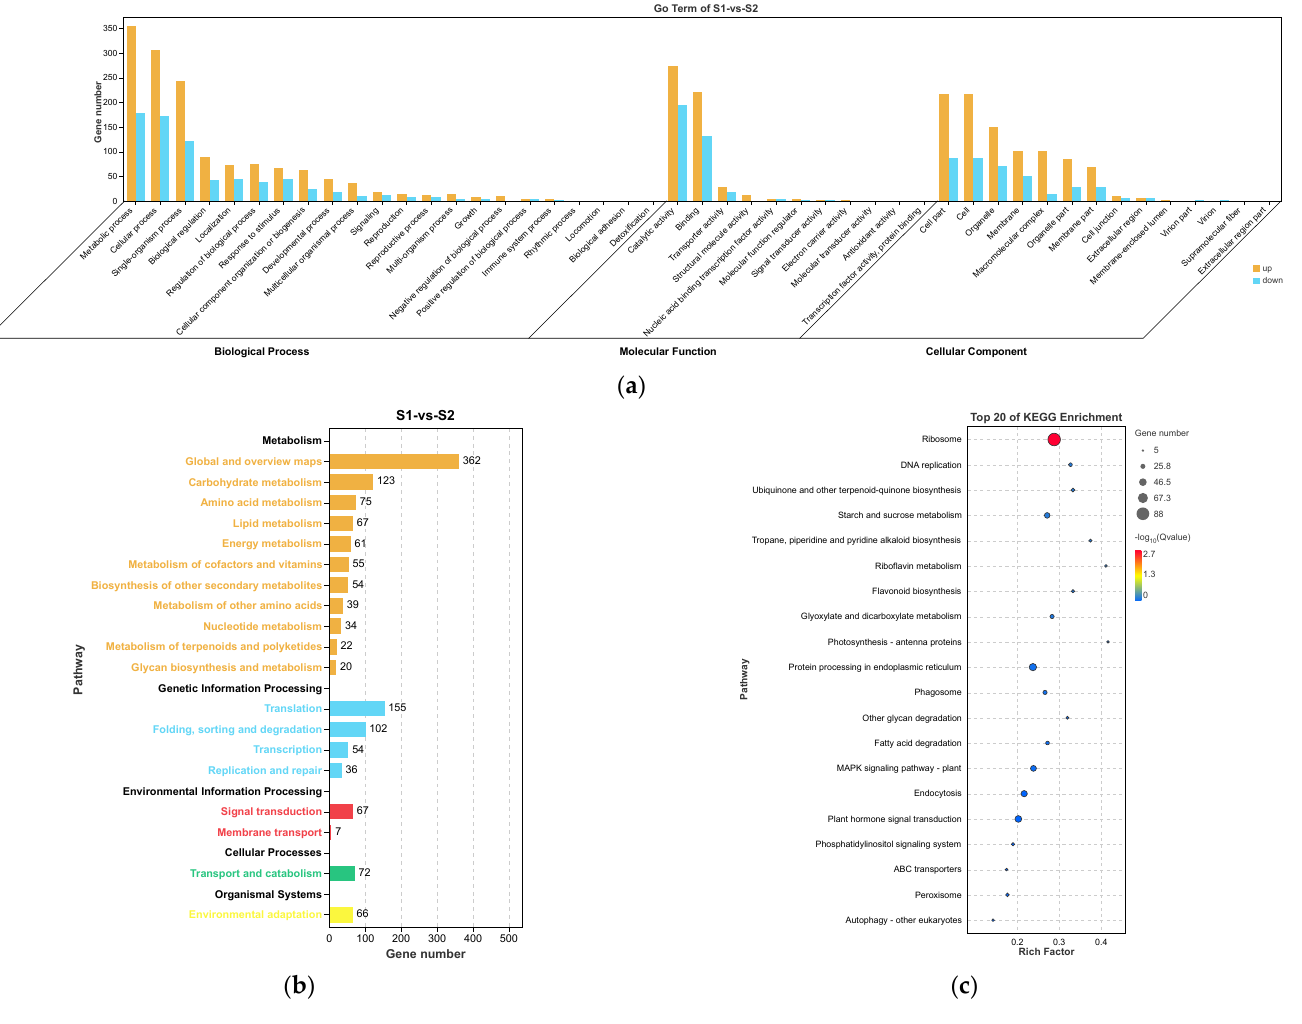
Figure 6. Gene Ontology (GO) enrichment ( a ), KEGG pathway annotation ( b ), and the top 20 KEGG pathways ( c ) of the DEGs in S1 vs. S2. The area of bubbles indicates the number of enriched DEGs, while the color of bubbles indicates the Q-value.